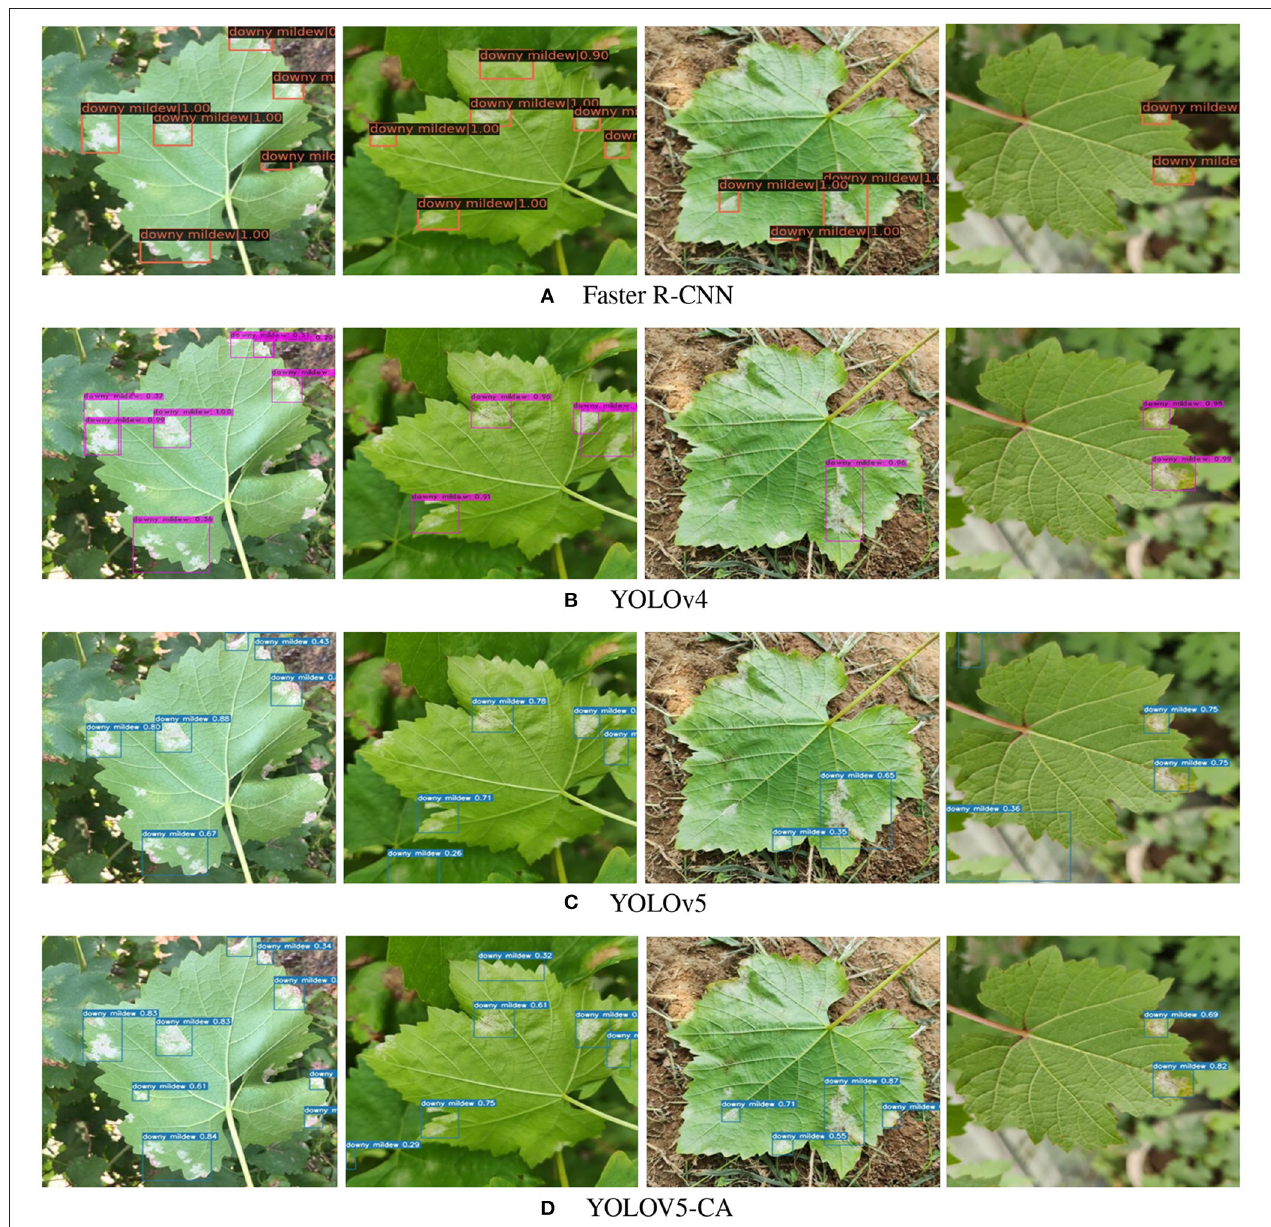
FIGURE 4 | Examples of different GDM detection attention methods. (A) Faster R-CNN, (B) YOLOv4, (C) YOLOv5, and (D) YOLOV5-CA.